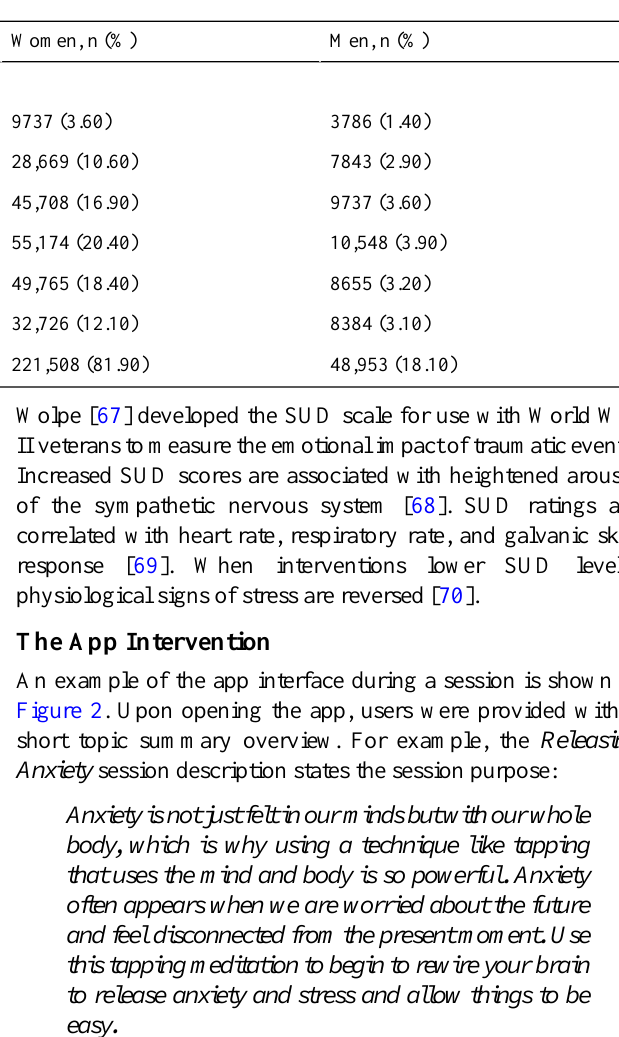
Table 1. Demographics of app users by age and gender